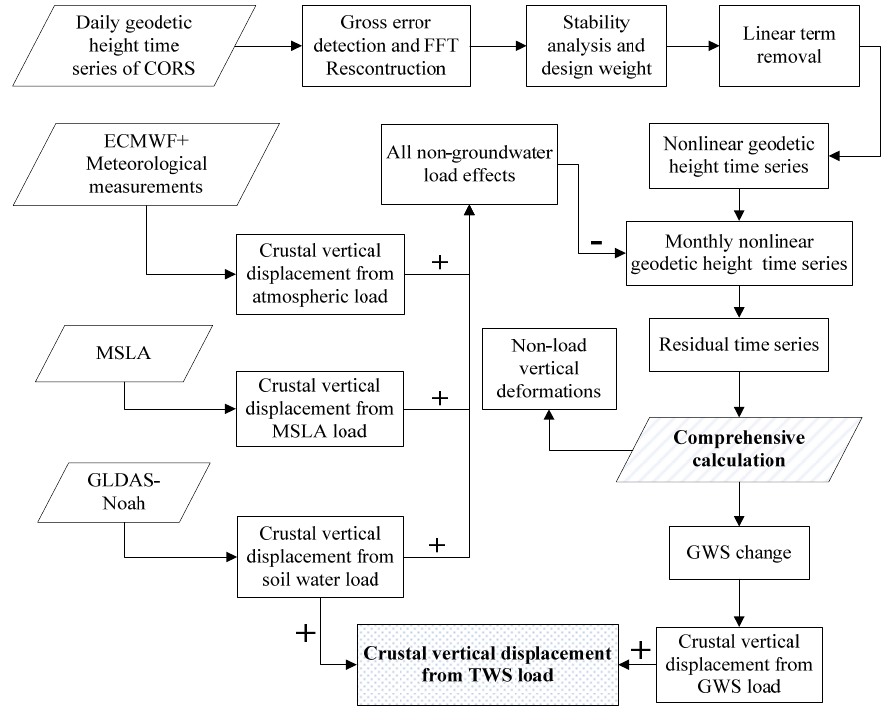
Figure 2. The main steps of calculating the vertical deformation of terrestrial water load based on the CORS network comprehensive calculation method.